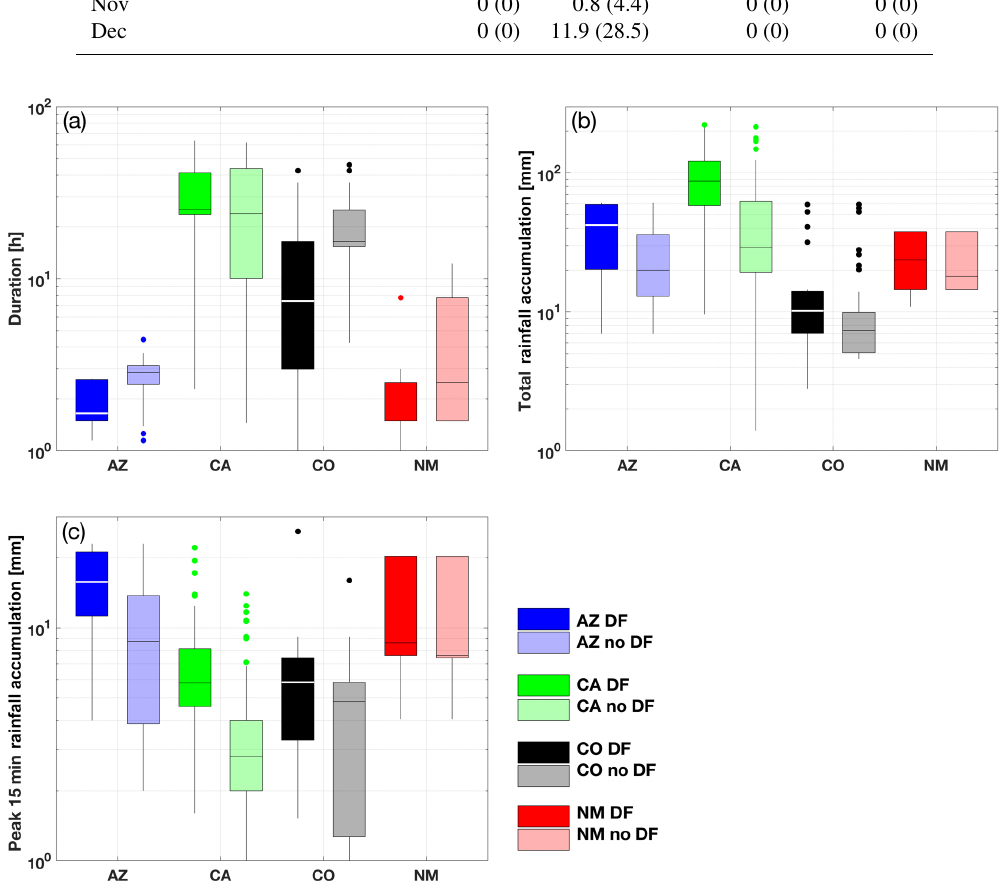
Figure 2. Box plot for (a) storm duration, (b) storm accumulation and (c) peak 15min storm accumulation for Arizona (blue), California (green), Colorado (black) and New Mexico (red). Dark (light) colors correspond to DF and noDF